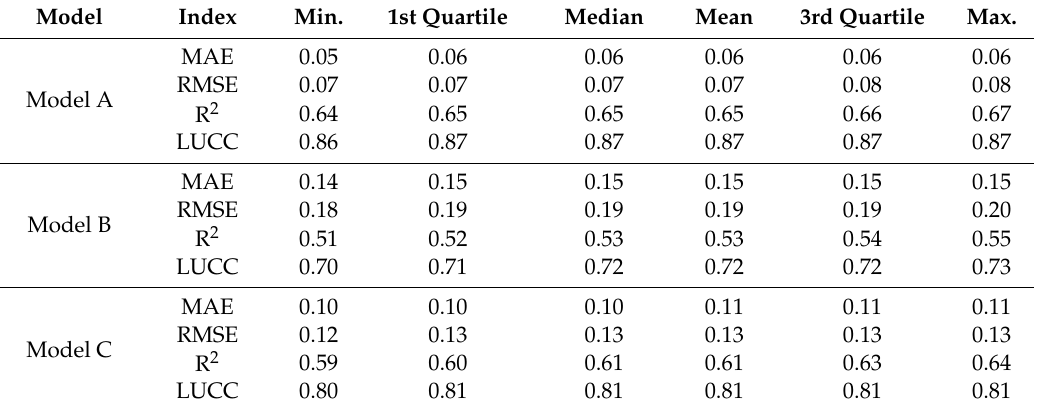
Table 3. Predictive quality of three boosted regression trees (BRT) models for SOC stocks. Model Index